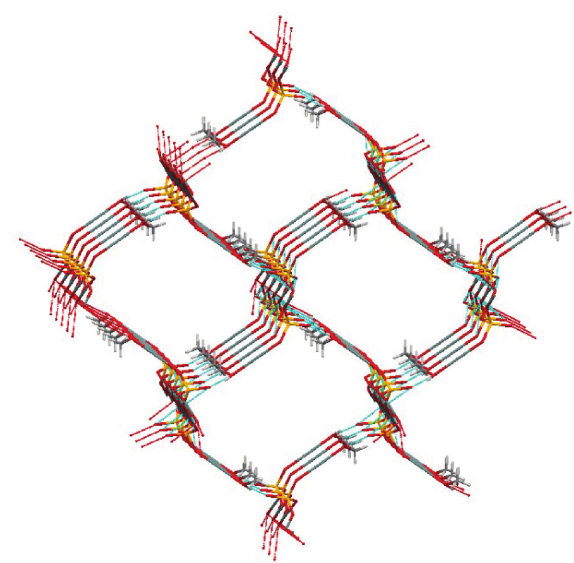
Figure 3: Mercury view of the grid-shaped network resulting from the presence of intermolecular hydrogen bonds (blue dotted) between polymeric chains of 1 . Phenyl groups are omitted for